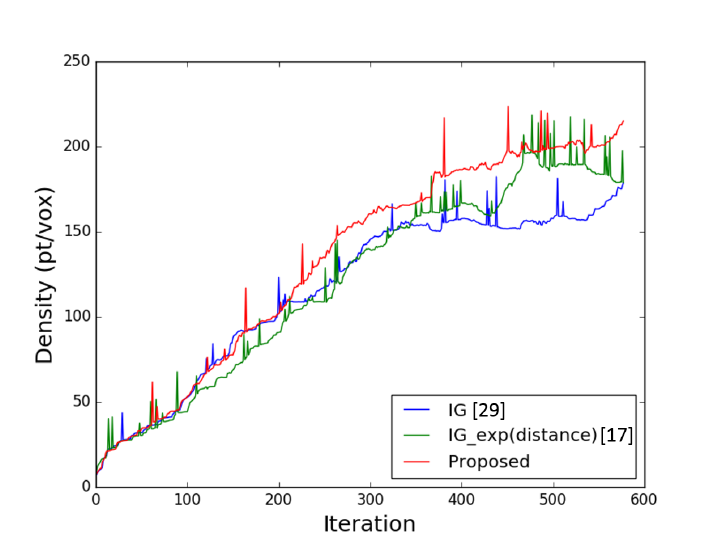
Figure 9. The voxel point density vs. the number iterations, showing the proposed approach’s performance as compared to other state-of-the-art utility functions.